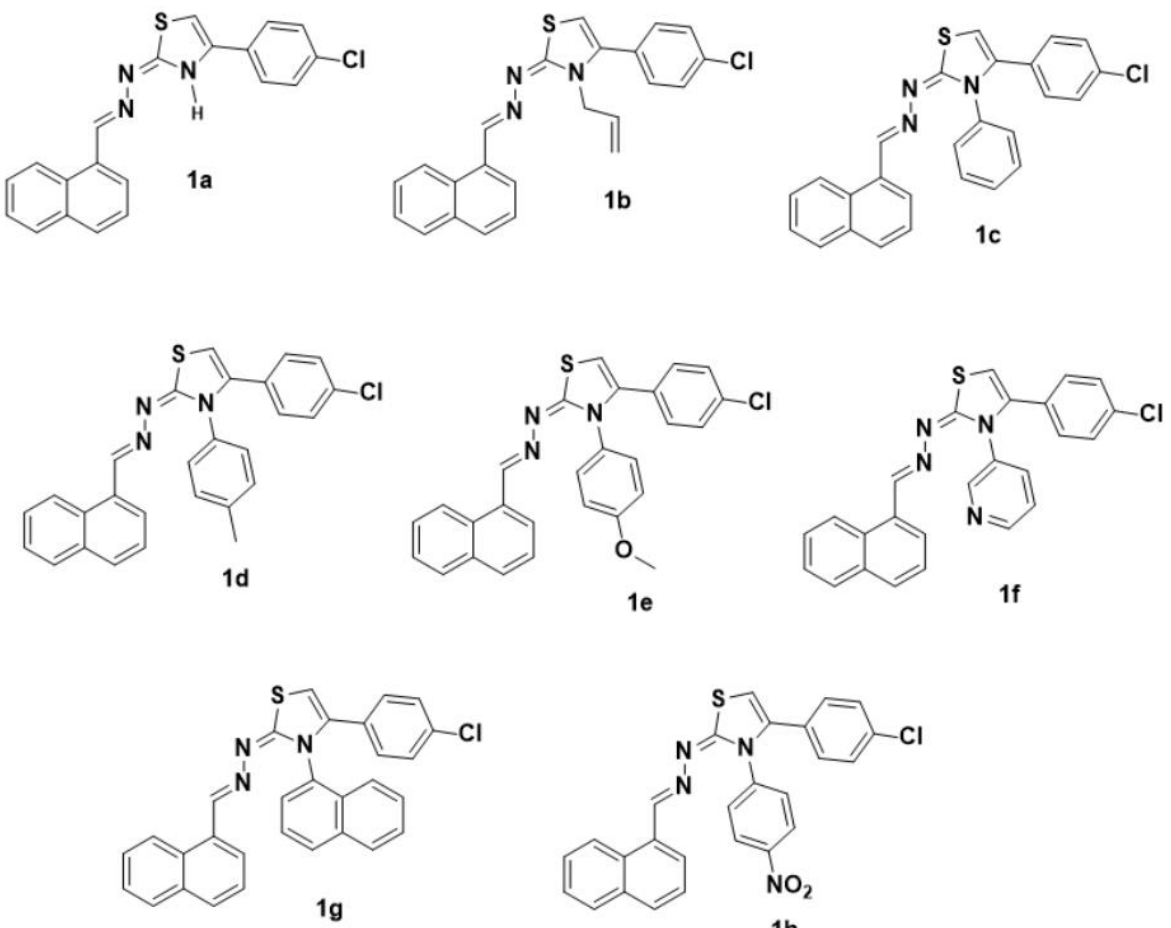
Figure 1. Chemical structures of thiazoles provided by